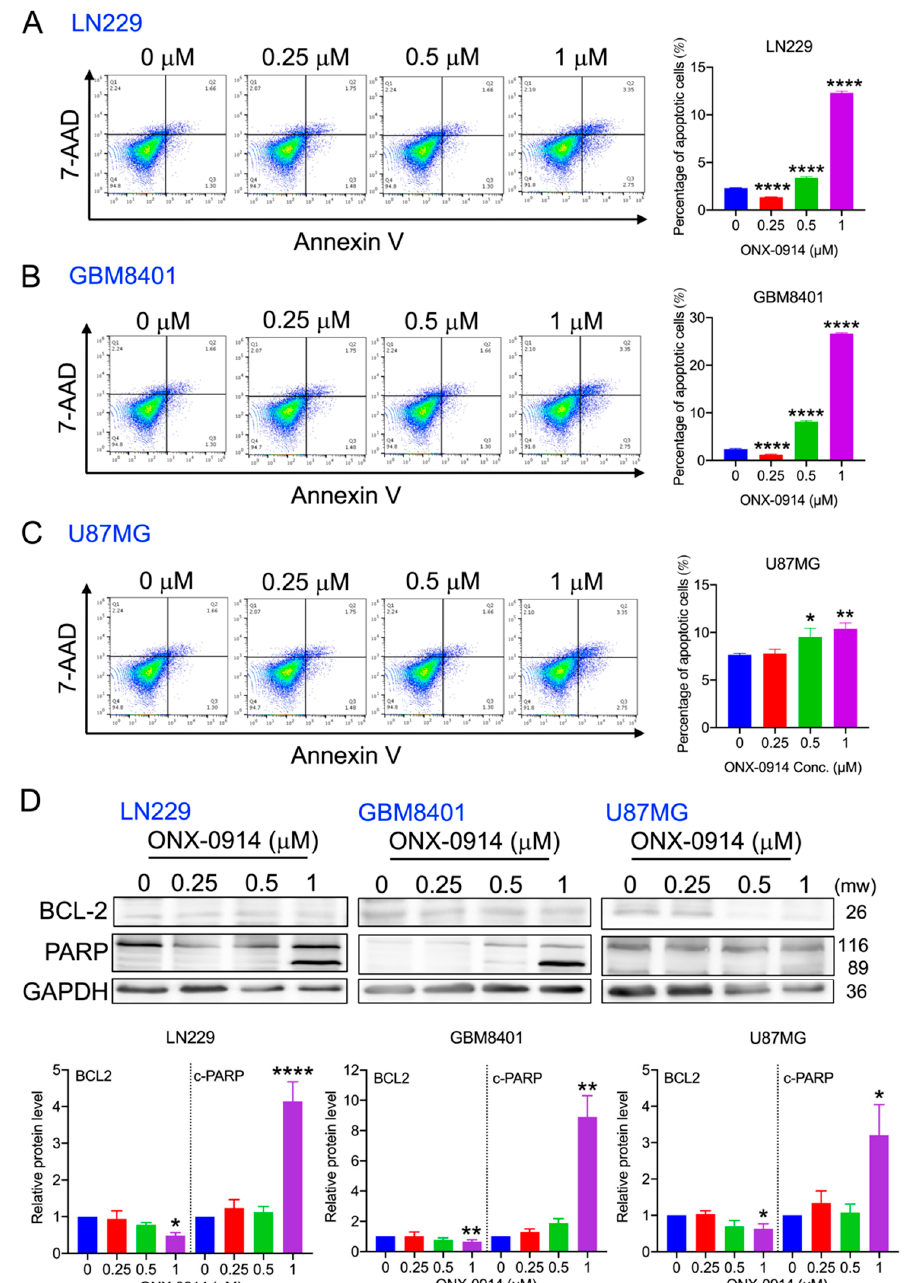
Figure 3. The effect of ONX-0914 on apoptosis in human glioblastoma cells. The percentage of apoptotic cell death was measured using Annexin V-APC/7-AAD staining. The percentage of apoptotic cells is shown in the bar diagram. ( A ) LN229, ( B ) GBM 8401, and ( C ) U87MG cells. ( D ) BCL-2 and cleaved PARP (c-PARP) protein expression was analyzed after ONX-0914 treatment for 24 h. GAPDH was used as a loading control. The lower panels show the quantitative results. *, p < 0.05; **, p < 0.01; ****, p < 0.0001 compared to the control group.